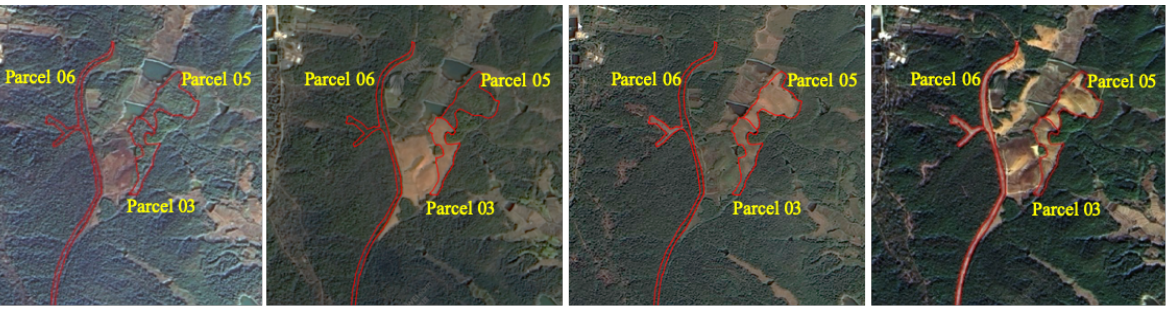
Figure 3. Parcel 02 in Xishuangbanna Nature Reserve